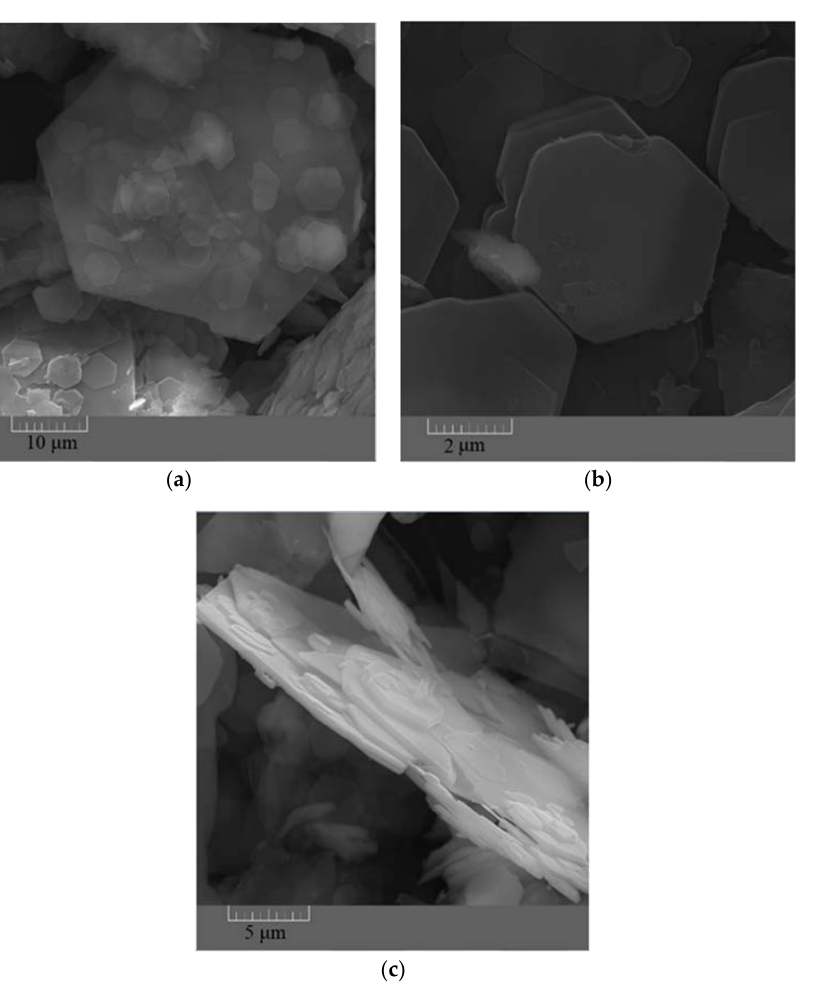
Figure 1. FESEM images showing shape ( a , b ) and thickness ( c ) of the synthesized ZHS nanoplates. The ZHS nanoplates were also characterized by FTIR (Figure 2). The broad IR band at 3200–3600 cm − 1 is related to the O ‐ H stretching of the intra ‐ layer or physically ‐ adsorbed water molecules. In addition, the bands at 1122 and 596 cm − 1 are attributed to the stretch ‐ ing and bending modes of sulphate ions, while the bands at 1000 and 790 cm − 1 are more probably related to Zn ‐ OH. Finally, the IR band at around 446 cm − 1 is related to Zn ‐ O [31].